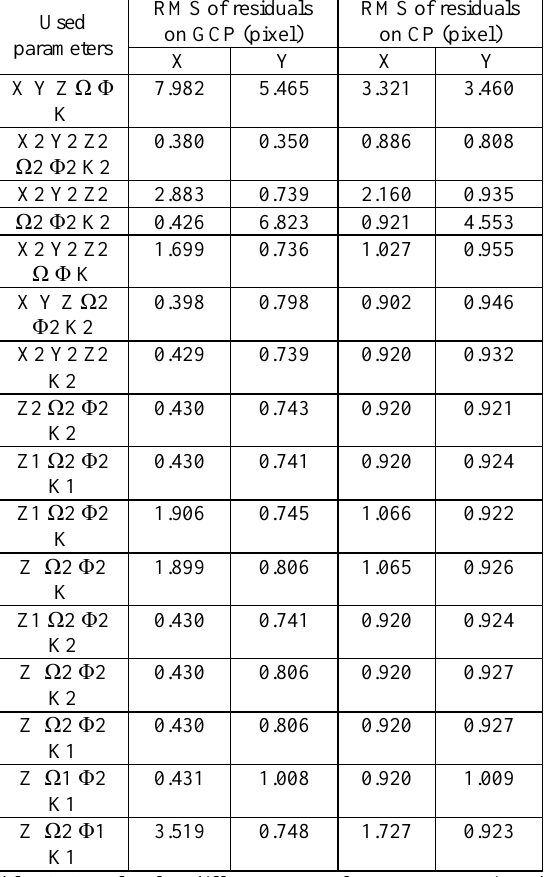
Table 4. Results for different sets of parameters using the second Toulouse